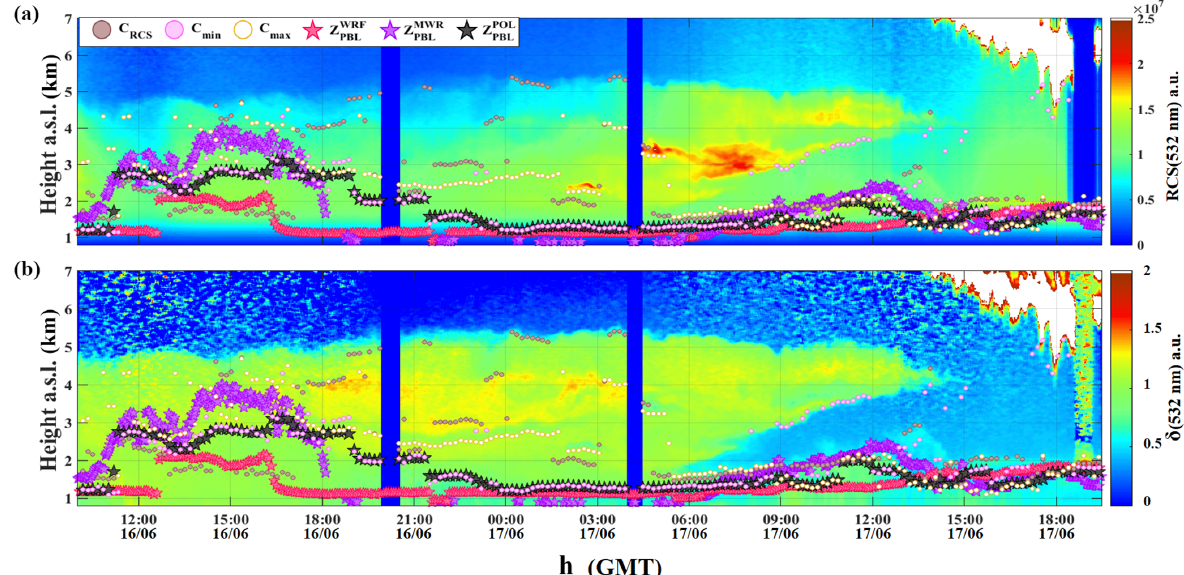
Figure 6. Temporal evolution of the range-corrected signal (RCS) (a) and the perpendicular-to-parallel signal ratio ( δ) (b) in the period 09:00UTC 16 June–20:00UTC 17 June 2013 (colour maps). The scatter plots represent the candidate for z PBL : C RCS (brown dot), C min (pink dot) and C max (ochre dot). The z PBL determined with POLARIS (black star), using MWR measurements (violet star) and derived from the WRF model (red star), is shown. The measure gaps are dark-current